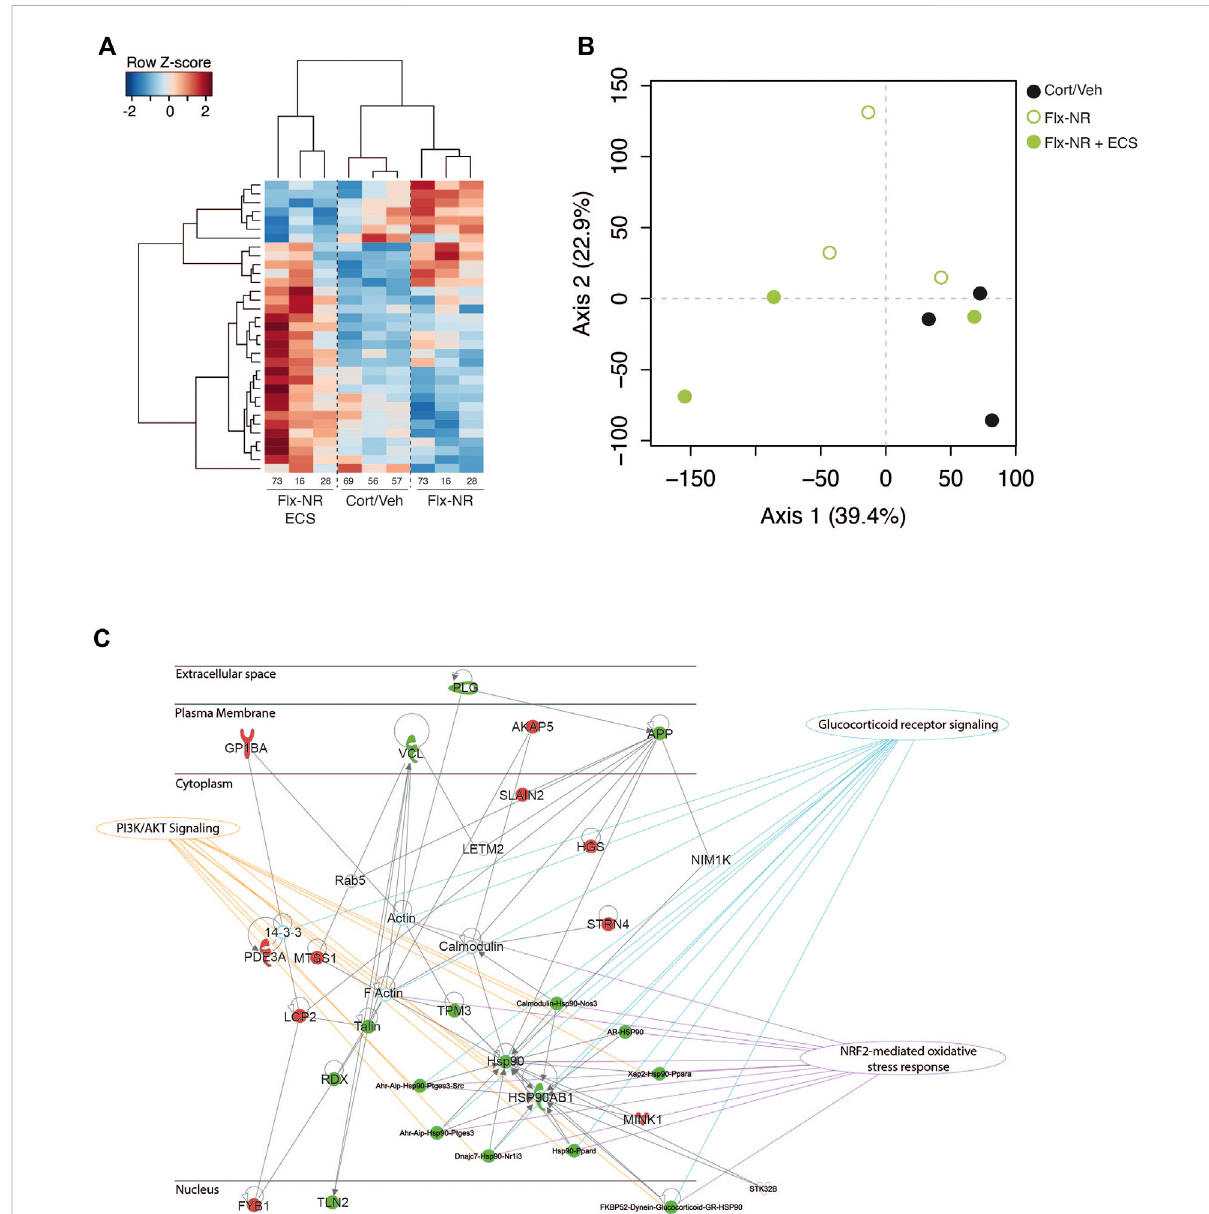
FIGURE 3 Peripheral proteomic changes after fl uoxetine exposure in responders and non-responders (A) Hierarchical bivariate clustering of expression pro fi lesofanimals(column)andproteins(rows)depictsthedifferencesbetweenCort/Veh,Flx-NR,andFlx-NR-ECSgroups.Ananimal ’ sexpressionis red for above-average values, and blue for below-average values (B) Principal Component Analysis of expression pro fi les revealed two main axis separating results. (C) Ingenuity Pathway Analysis revealed a molecular interaction network based on differentially expressed proteins. This protein network was signi fi cantly connected to the following canonical pathways: glucocorticoid receptor signaling, PI3K/Akt signaling and NRF2- mediated oxidative stress